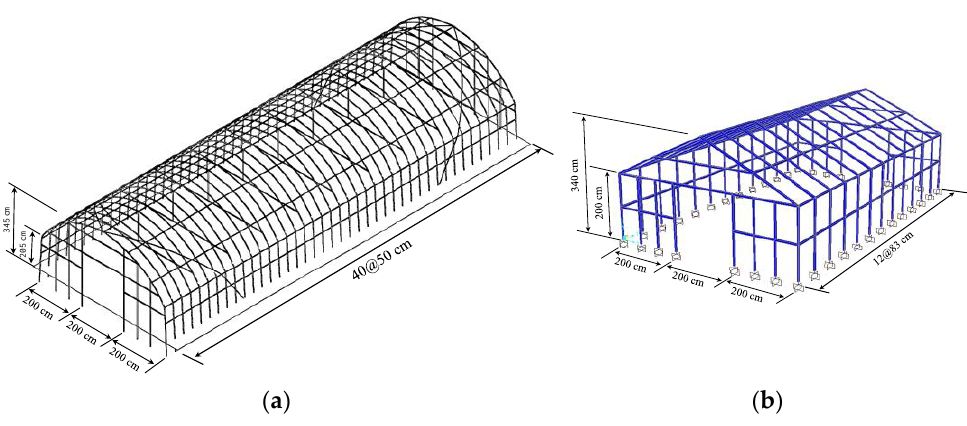
Figure 2. ( a ) UP-type standard greenhouse; ( b ) proposed composite plastic greenhouse. Table 3. Self-weight and the first three modal periods of the greenhouse models (s).